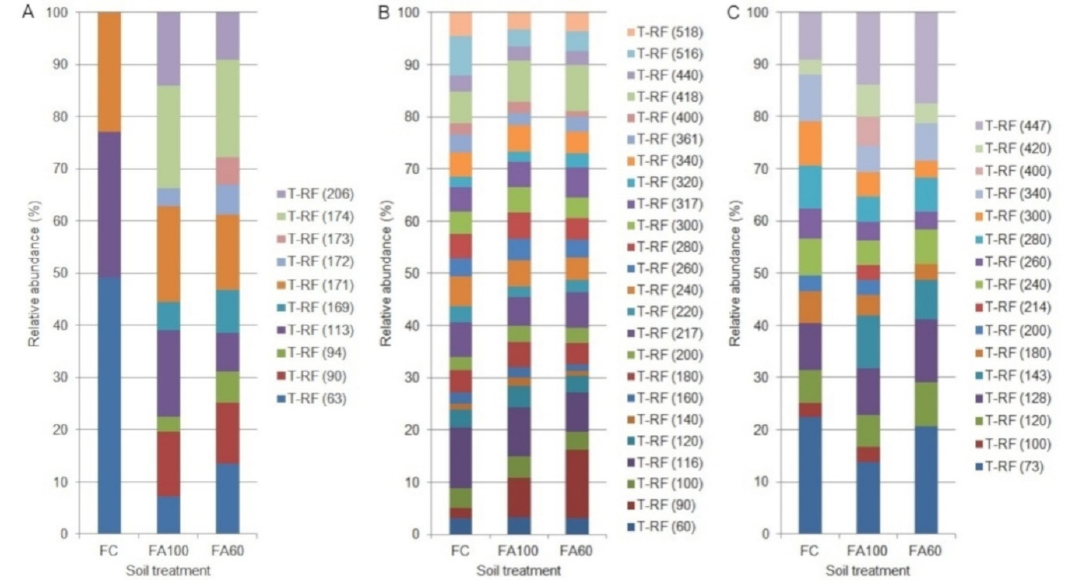
Figure 4. Relative abundance of the terminal restriction fragments obtained after HaeIII digestion for the bacterial ( A ), archaeal ( B ) and fungal ( C ) communities in Brunic Arenosol soil. Explanation: FC—optimal dose of fertilizer, FA100—optimal dose of fertilizer enriched with microorganisms, FA60—fertilizer enriched with microorganisms (dose reduced by 40%).